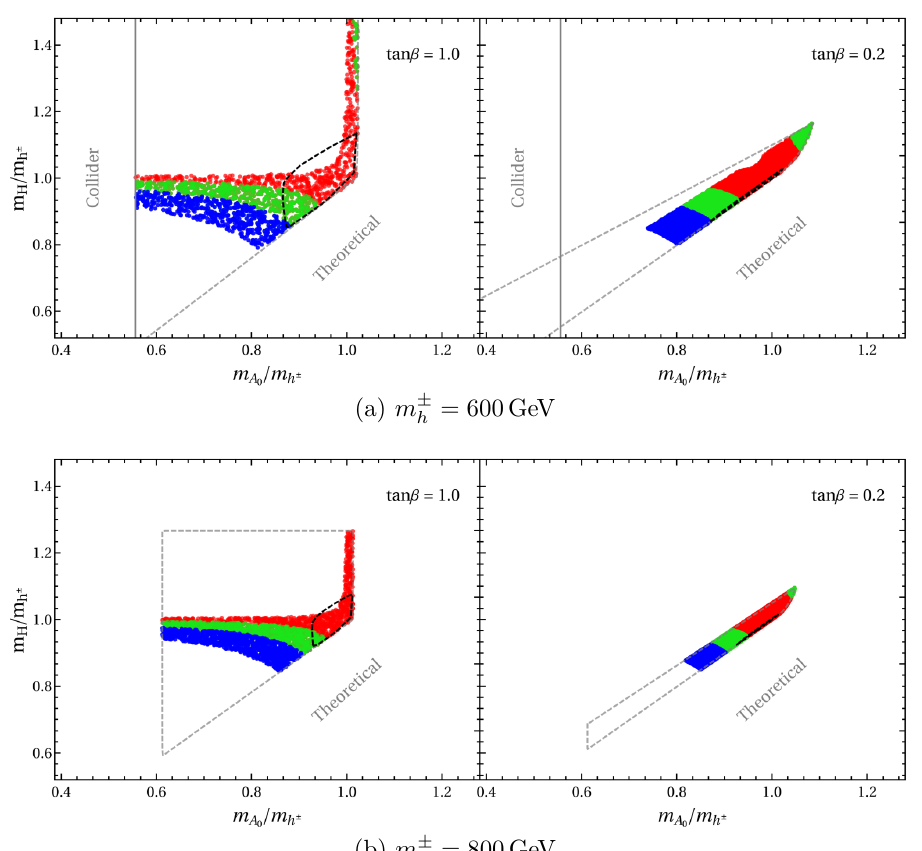
Figure 11 . Summary plots when all constraints are enforced. Outside the dashed lines, the region is excluded by theoretical bounds. The gray dashed lines correspond to imposing λ max = 4 π at the EW scale while the black dashed lines correspond to imposing λ max = 4 π both at the EW scale and at the v χ = 100 TeV scale. The left region from the continuous gray line is excluded by collider bounds. The mass of the charged scalar and tan β are chosen as indicated in the